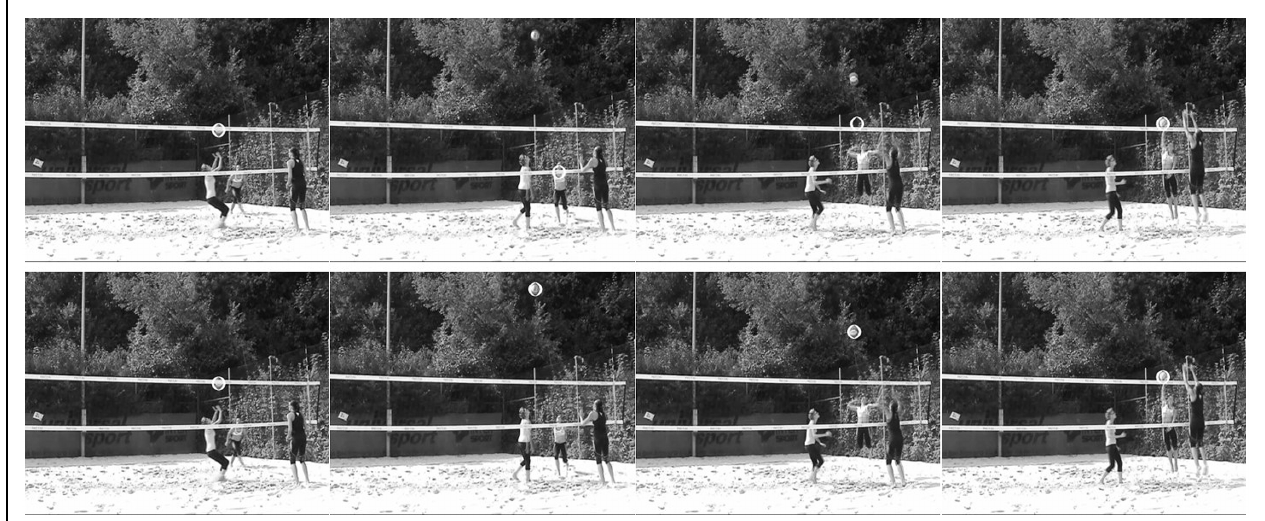
FIGURE 4 | Functional (top) and dysfunctional (bottom) visual-cue paths at the first frame of phase P0 (set), P1 (run-up), P2 (attack), and the last frame of P2 (attack). In P0–P2 of the functional path, the ball, the attacker, and the anticipated ball-hand-contact are cued, respectively; in P0–P2 of the dysfunctional path, the ball is always cued. Original tapes were colored with red